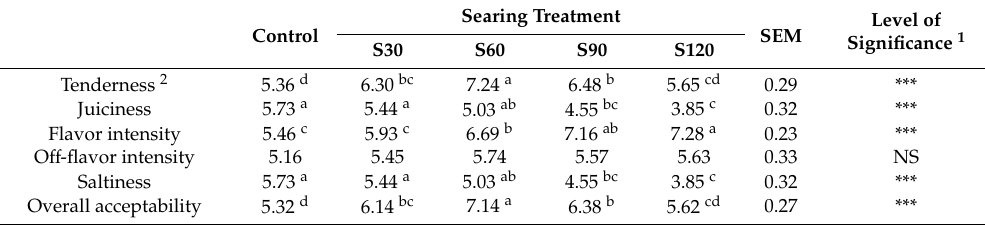
Table 4. E ff ects of searing process on sensory quality characteristics of sous-vide cooked patties. Control